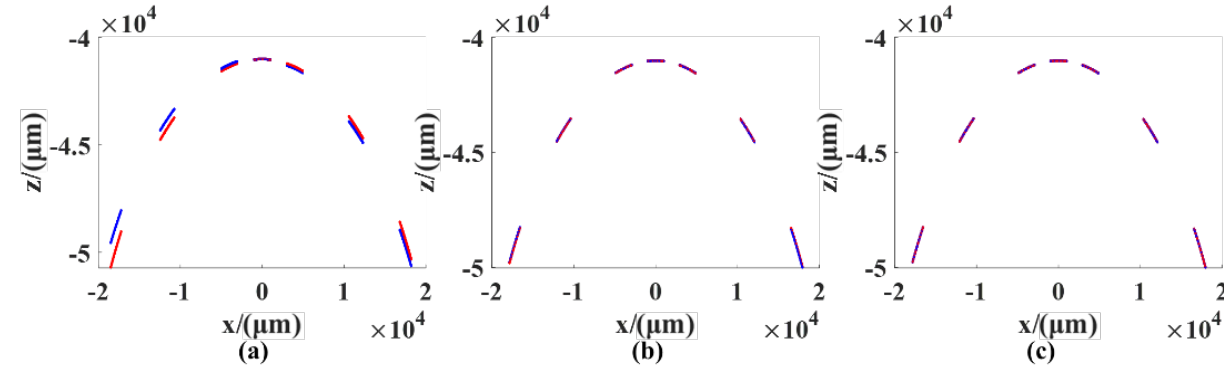
Figure 8. A photograph of the measurement system.